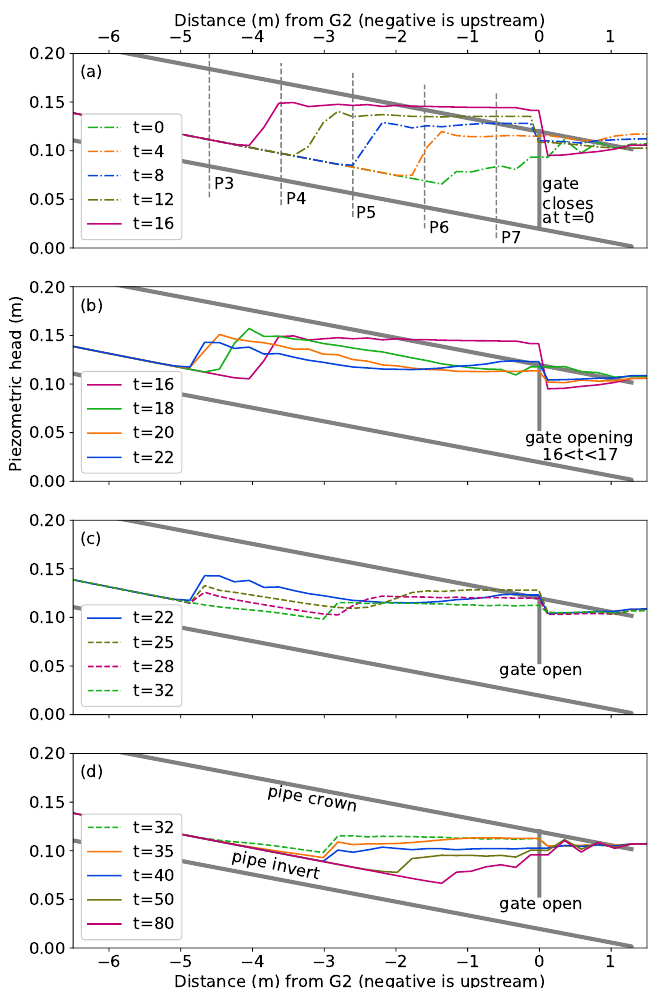
Figure 2. Profiles of piezometric head evolution for simulation of Case D1: ( a ) is progression from steady flow just before t = 0 s (with gate open to 0.033 m) showing upstream propagation of hydraulic jump after gate closes at t = 0, ( b ) is initial slumping of subcritical flow shortly after gate re-opening at t = 16 s, ( c ) secondary transition phase with secondary bore, and ( d ) is drawdown to the steady condition. P3–P7 are locations of pressure sensors where experimental data were